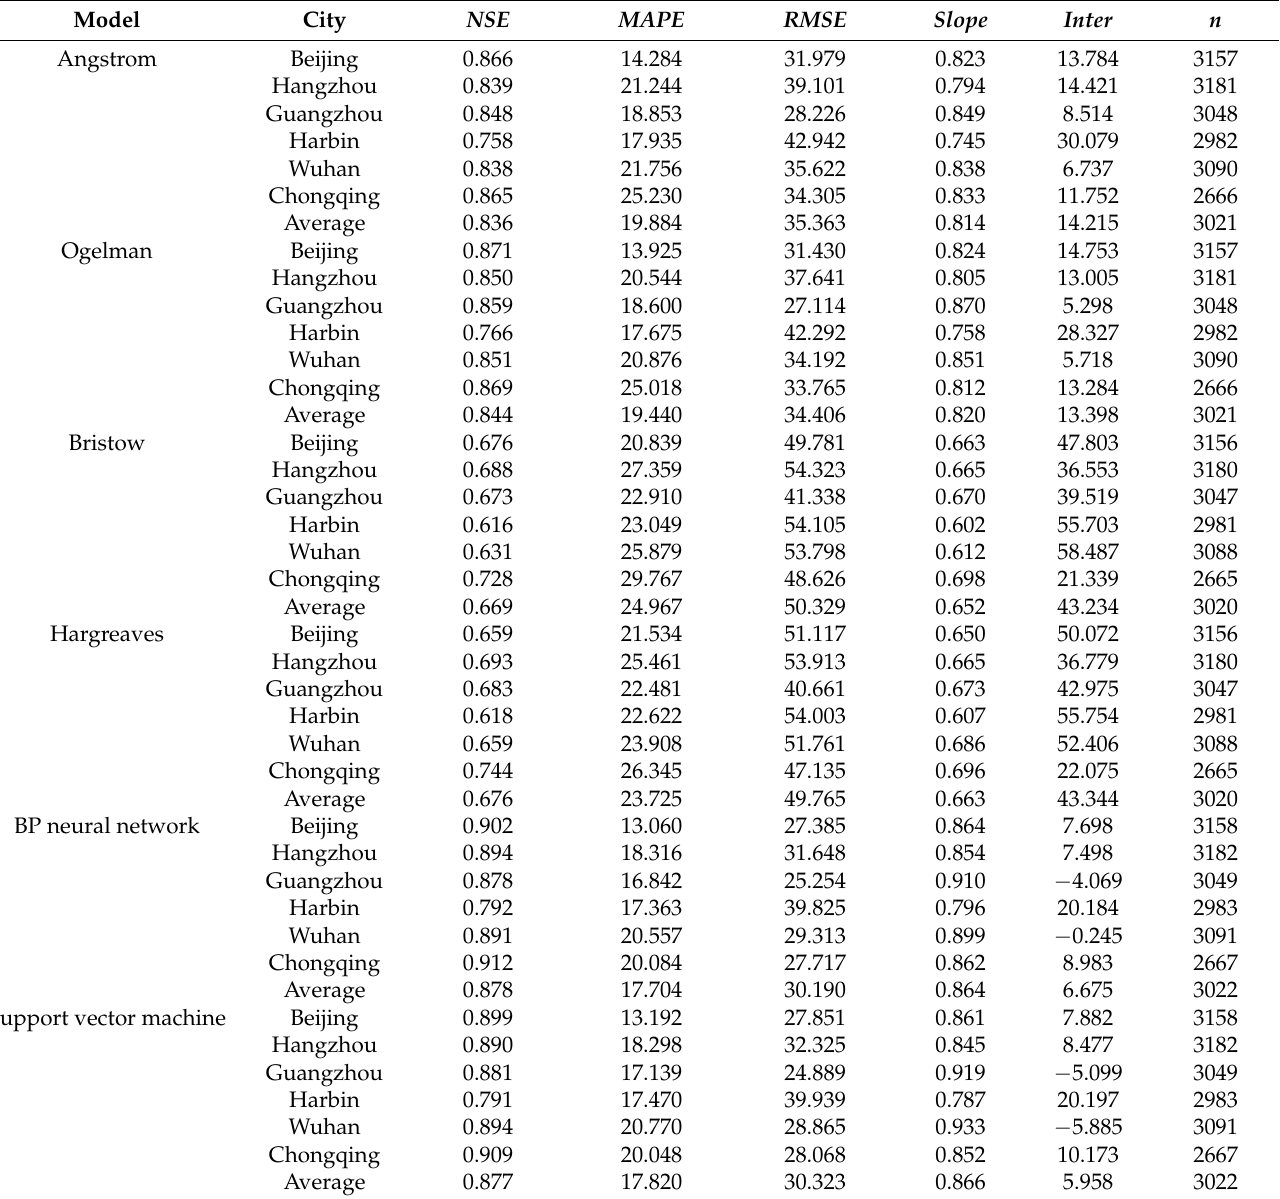
Table 4. Validation results of the empirical models and machine-learning methods on estimating solar